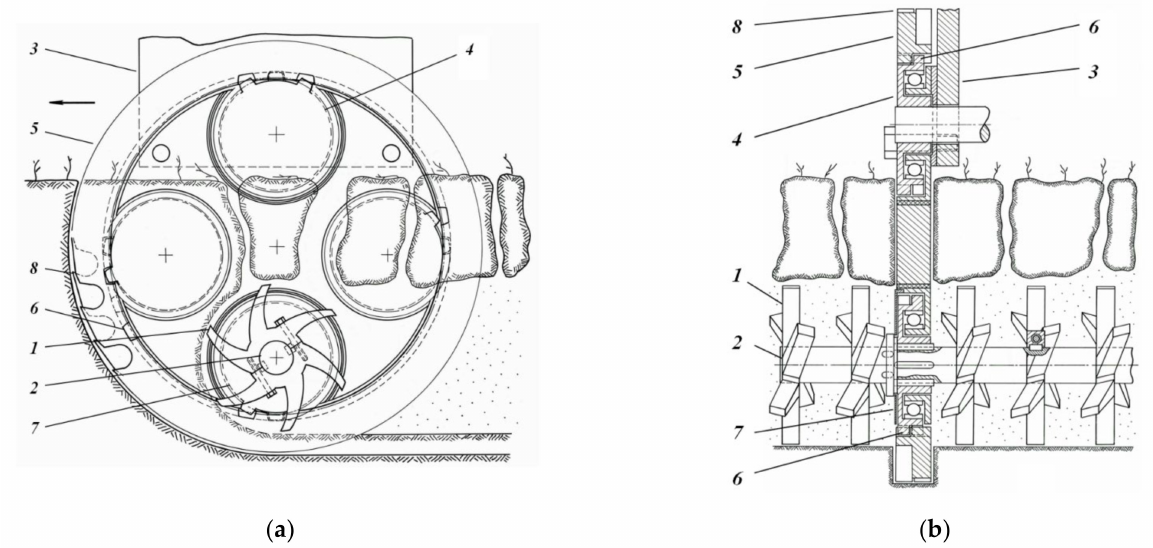
Figure 8. Intra-soil milling machine PMS–280, ( a ) side view, ( b ) front view. Mills 1; shaft 2; frame 3; driving gear 4; ring cogwheel 5; internal gearing 6; driven gear 7; external cutter